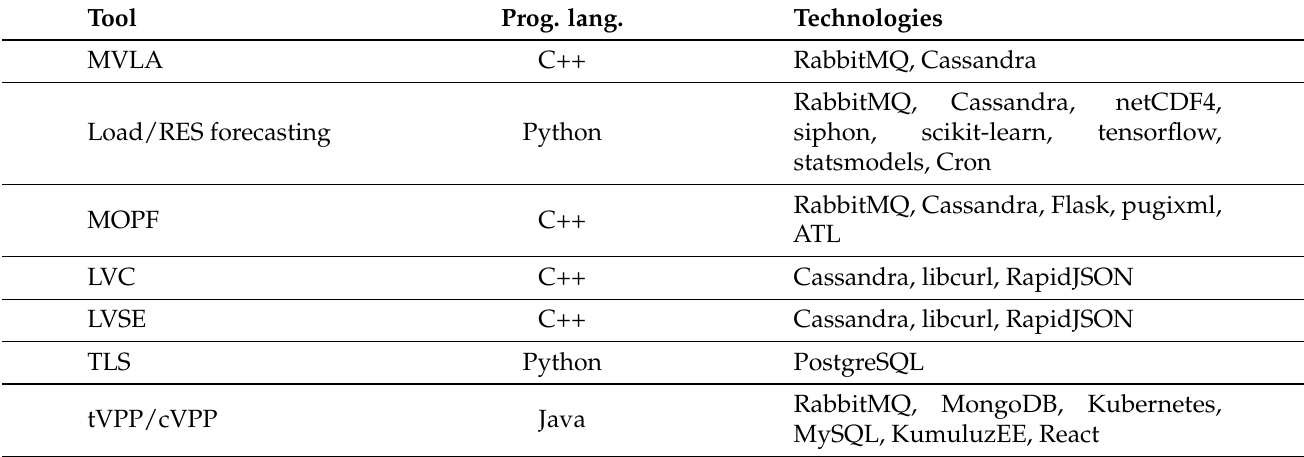
Table A1. Programming languages and technologies of InteGrid tools Tool Prog.